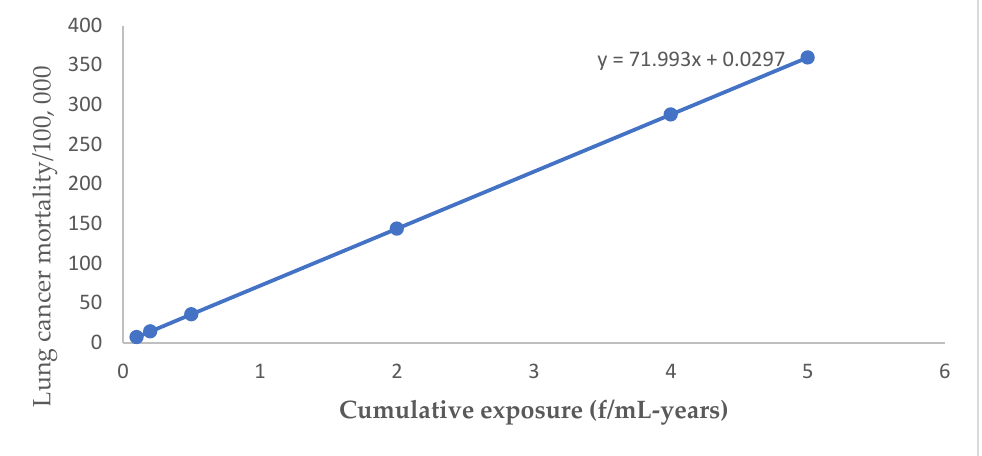
Figure 2. Mesothelioma mortality by cumulative exposure linear regression equation.